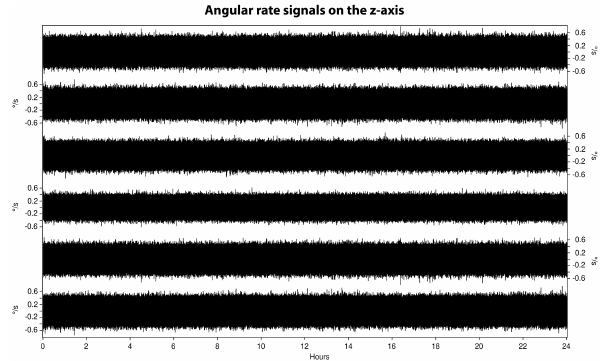
Figure 3. 24h angular rate signals ( z axis) recorded by the six MEMS gyroscope here